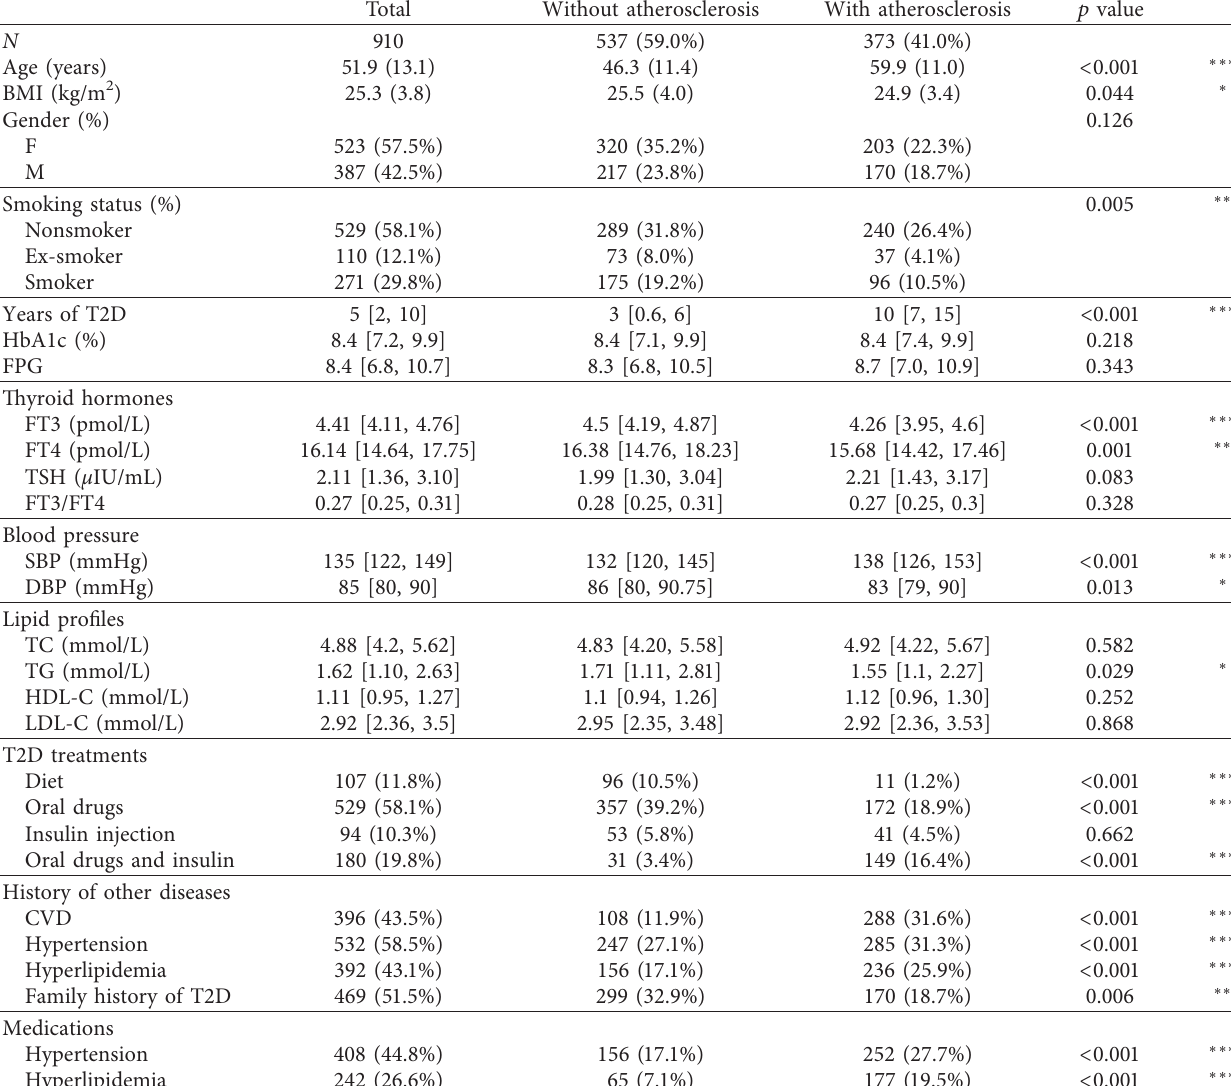
Table 1: Anthropometric characteristics of the study population with and without previously diagnosed